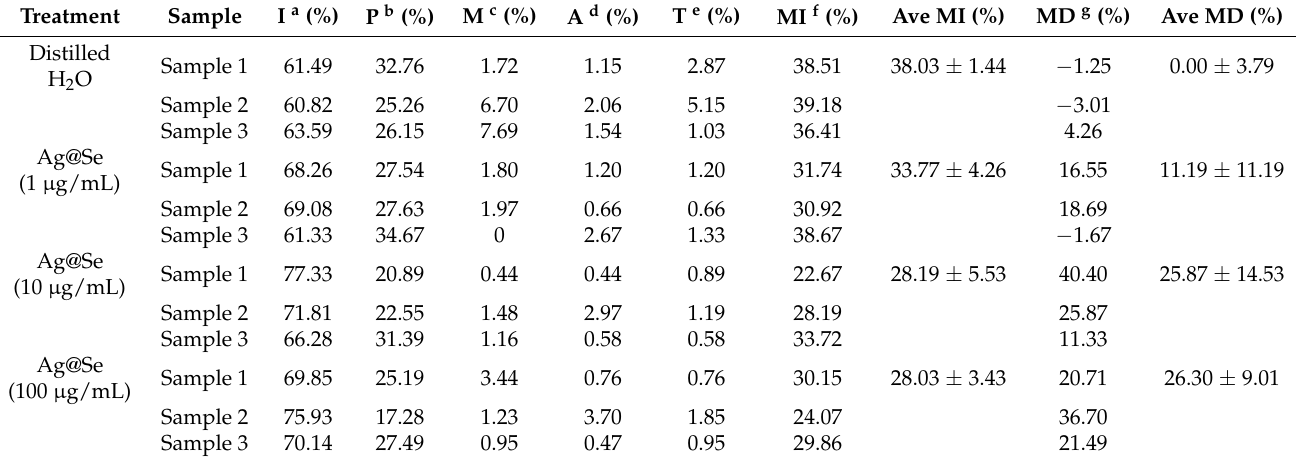
Figure 5. Cytotoxicity assay of Ag@Se NPs,5-FU and the plant extract in ( a ) HEK293 and ( b ) MCF-7 cells. Data are repre- sented as mean percentage cell viability ± SD ( n = 3). * p < 0.05 when compared to the 5-FU standard.